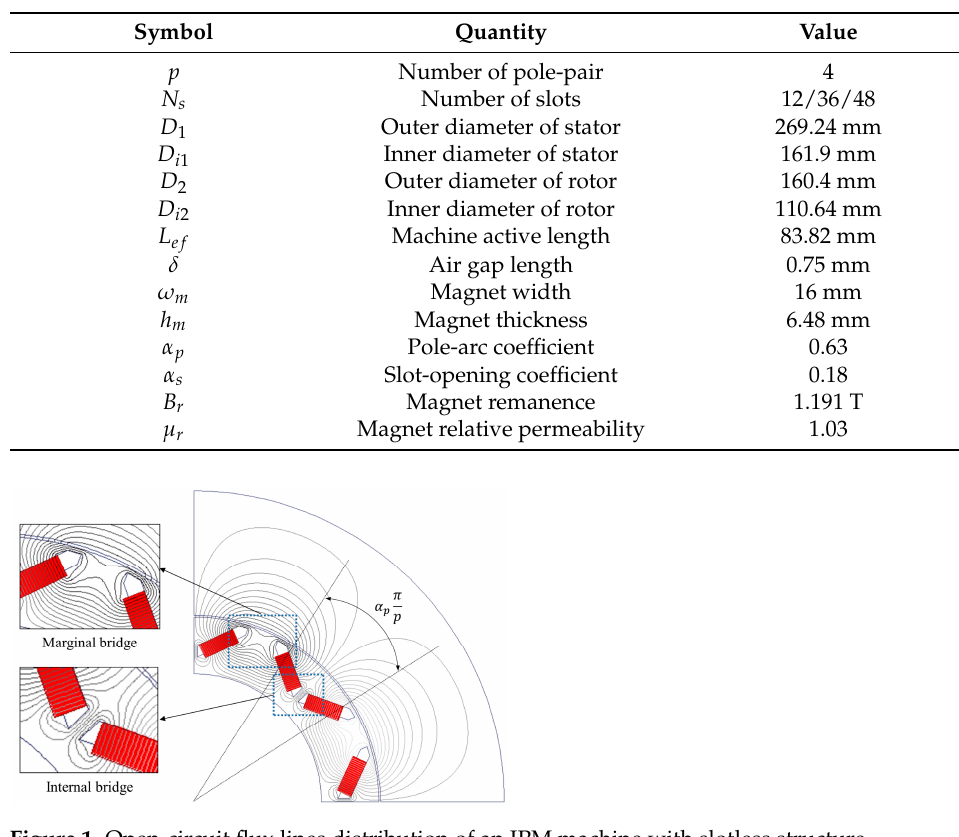
Figure 1. Open-circuit flux lines distribution of an IPM machine with slotless structure.